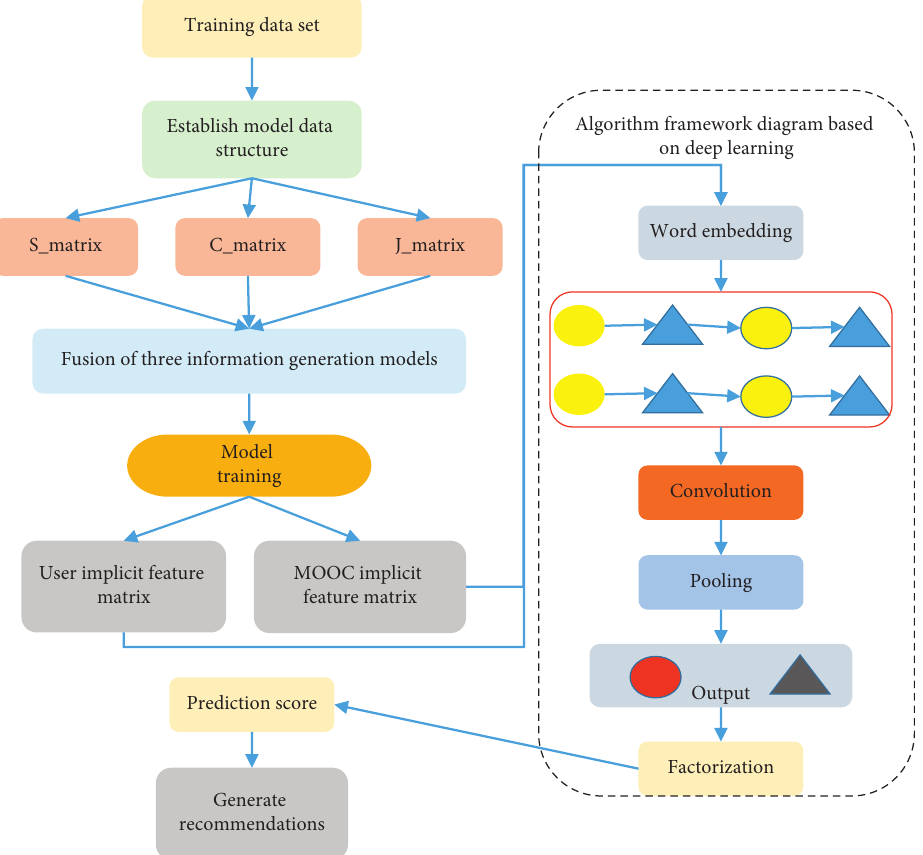
Figure 3: Framework diagram of collaborative filtering recommendation based on deep learning.